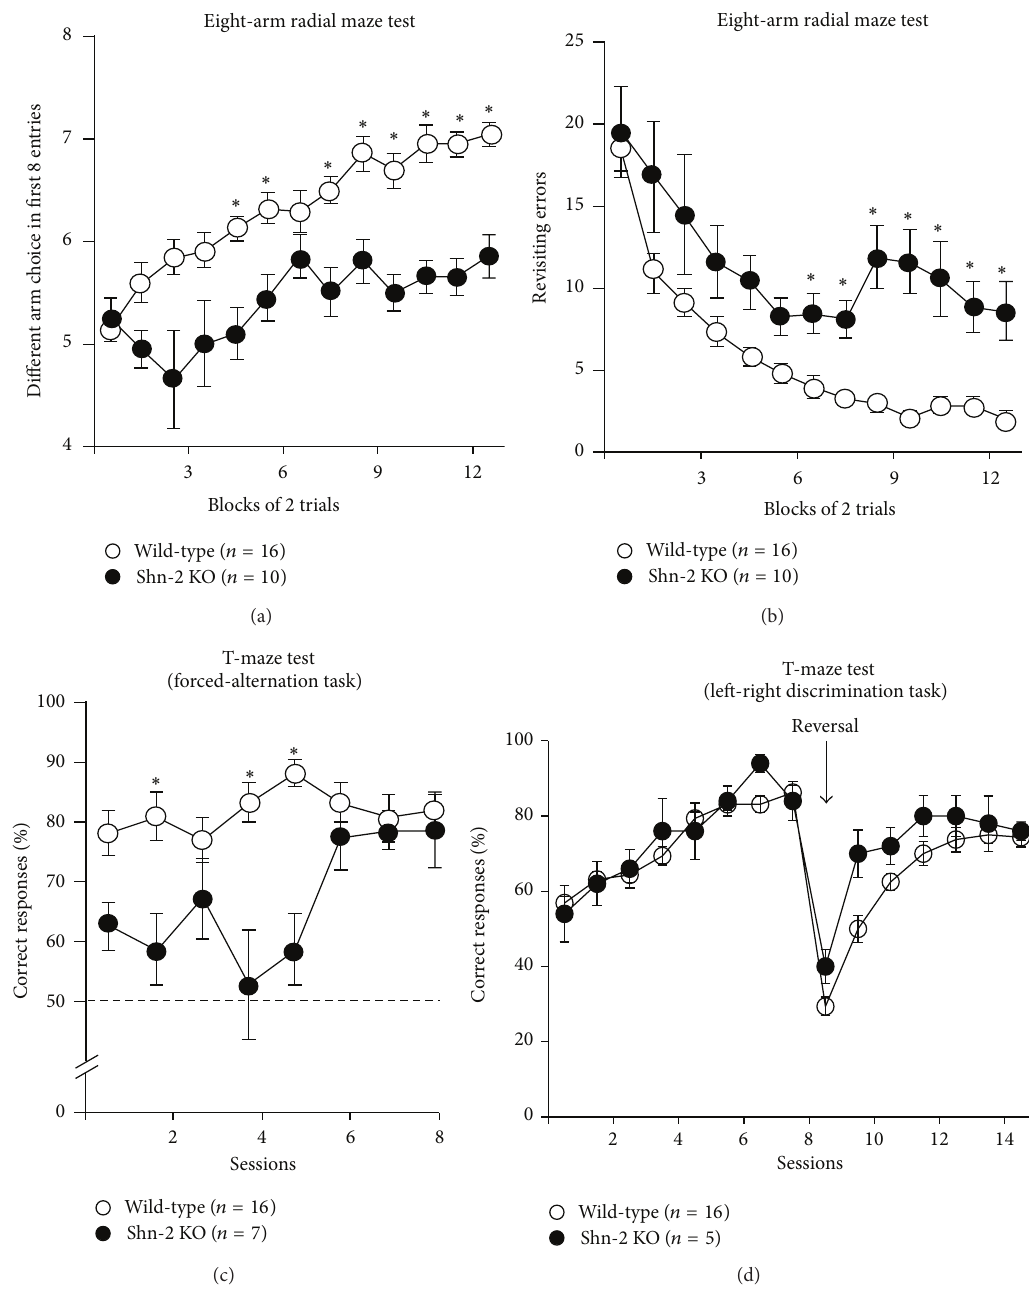
Figure3:ImpairedworkingmemoryperformanceinShn-2KOmice.(a)Inthespatialworkingmemoryversionoftheeight-armradialmaze, compared to controls, Shn-2 KO mice performed significantly worse with respect to the number of different arm choices in the first 8 entries (genotypeeffect:F 1,24 =62.104, 𝑃 < 0.0001 ).(b)Mutantsmadesignificantlymorerevisitingerrorsthancontrols(genotypeeffect:F 1,24 =45.597, 𝑃 = 0.1345 ).(c)Shn-2KOmicealsoshowedpoorworkingmemoryperformance 𝑃 < 0.0001 ;genotype × trialblockinteraction:F 12,228 =1.470, in the T-maze forced-alternation task (genotype effect: F 1,21 = 20.497: 𝑃 = 0.0002 ; genotype × session interaction: F 7,147 = 3.273: 𝑃 = 0.0029 ). (d) Shn-2 KO and wild-type mice were comparable in the left-right discrimination task (genotype effect: 𝐹 1,19 = 0.209 , 𝑃 = 0.6529 ) and reversal learning (genotype effect: 𝐹 1,19 = 5.917 , 𝑃 = 0.0251 ). Asterisks indicate statistical significance determined using the Student’s 𝑡 -test with a correction for multiple comparisons in each block (a, b) and each session (c) ( ∗ 𝑃 < 0.05 ). Adapted from Takao et al.